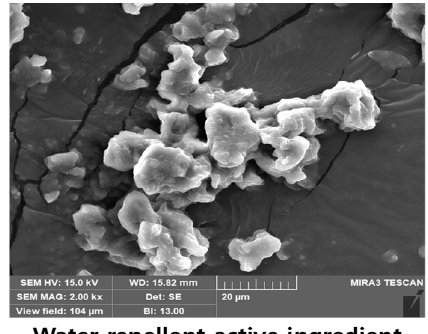
Figure 14. Water repellent active ingredient.